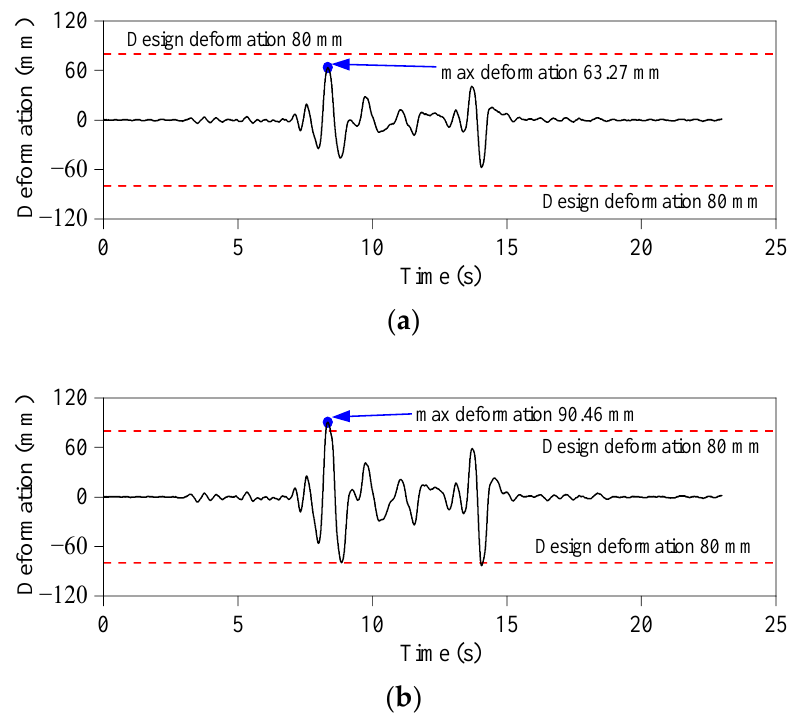
Figure 13. History of displacement of the LNR subjected to: ( a ) Kobe_NP_0.60 g; ( b ) Kobe_NP_0.80 g. Figure 14 displays the maximum displacements of the viscous dampers subjected to excitations with different earthquake levels. The displacement response of the four viscous dampers affords similar distributions under different earthquake levels. Moreover, displacements caused by NF ground motions were significantly larger than those caused